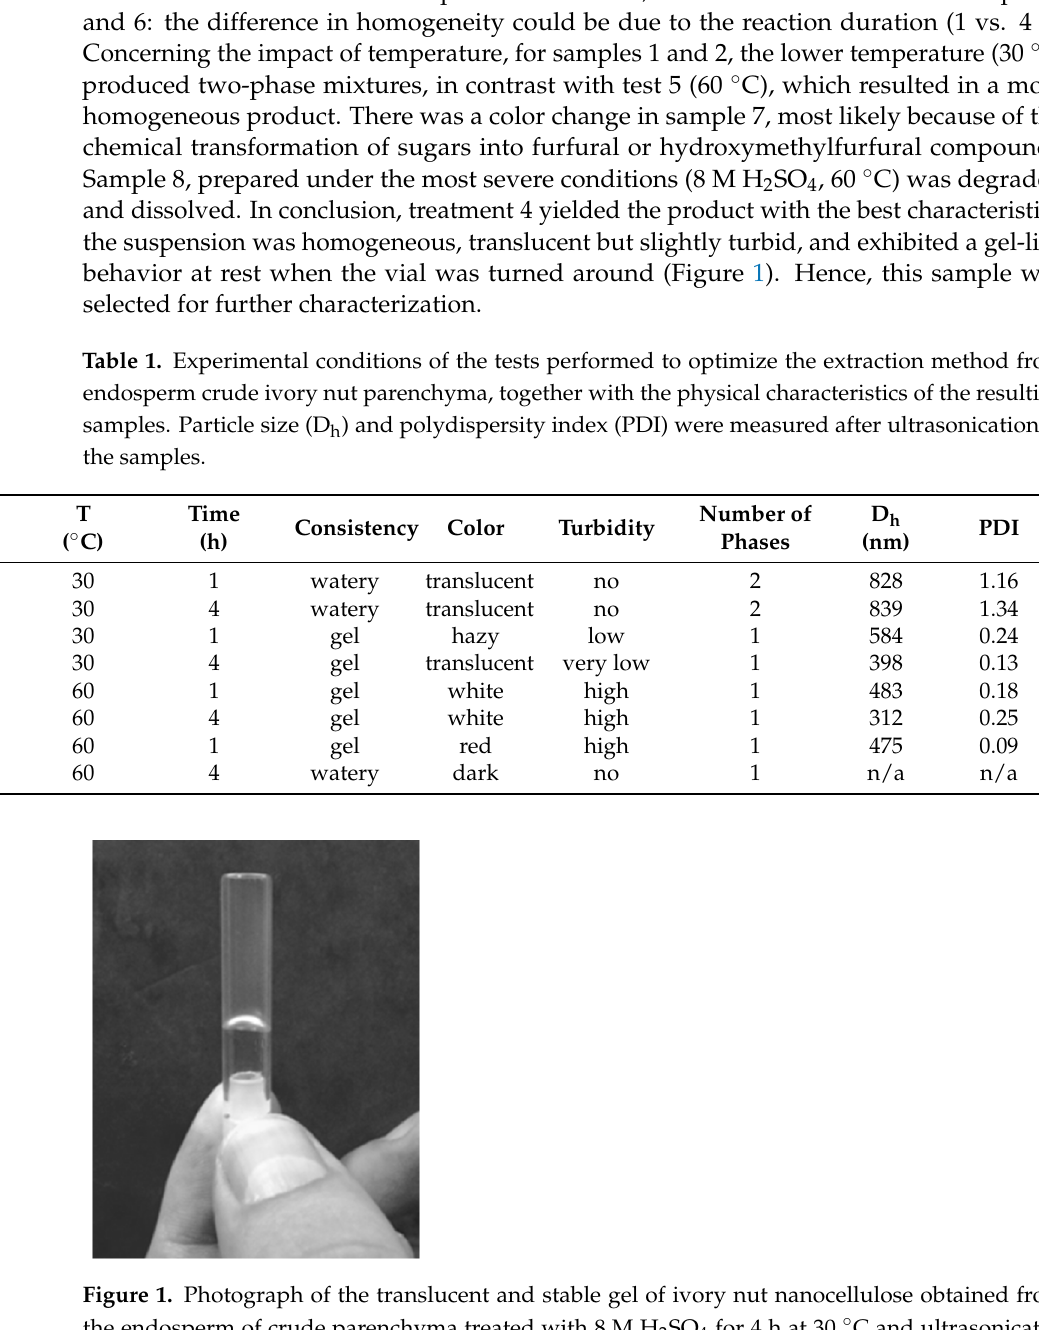
Figure 2. ( a–c ) TEM images of a negatively stained preparation of ivory nut nanocellulose extracted from the endosperm of crude parenchyma treated with 8 M H 2 SO 4 for 4 h at 30 °C and ultrasoni- cated. The image in c shows an individual nanofibril (left) as well as a bundle of three (right). 2.2.2. Structural Analyses The XRD pattern recorded from the ENC fraction (Figure 3a) was very similar to that of other parenchymal specimens [19,30–32]. Based on the Miller indexing of native cellu- lose I β [33], the lower-angle 11(cid:3364)0 and 110 reflections were merged into one another, forming a broader peak at about 15.8°. The higher broad peak at about 21.8° could be indexed as 200 , with a contribution from the overlapping 102 reflection. Finally, the characteristic 004 reflection was located at 34.8°. Apart from the 004 peak, the shift of the broader XRD reflections with respect to those of cellulose I [34], previously reported for the parenchymal cellulose from blackberry ( Rubus fruticosus L.) [35] and alkali-treated fibers of grapefruit ( Citrus grandis L.) Osbeck) albedo [32], suggested that the structure of the ivory nut cellulose resembled that of cellulose IV 1 , a less ordered form of cellulose I [36].